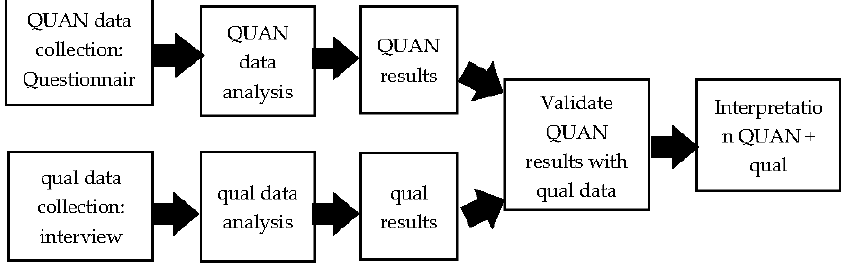
Figure 1. Procedural Diagram of the Proposed Convergent Parallel